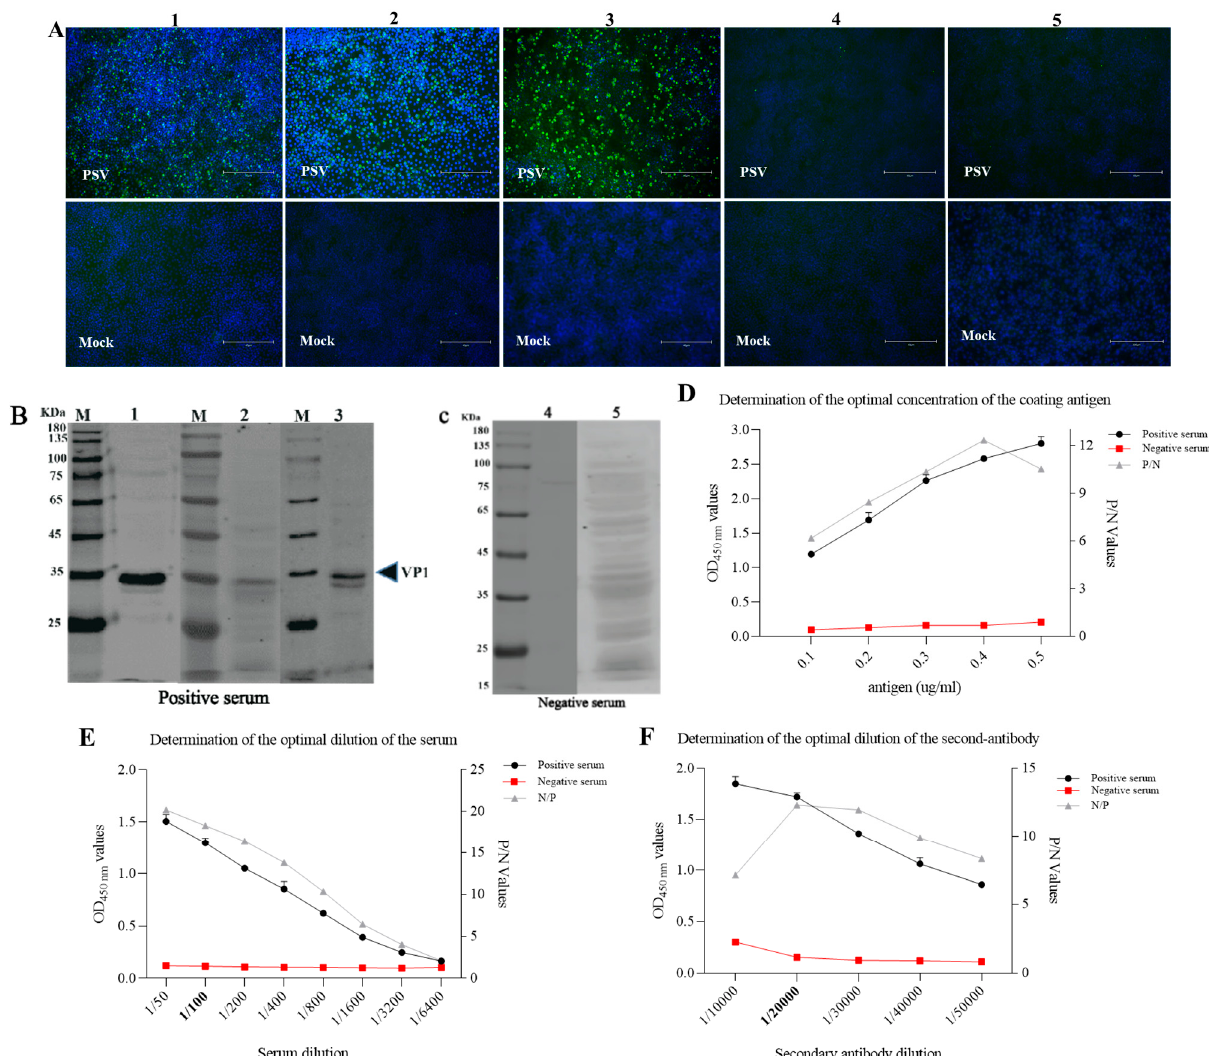
Figure 6. Optimization of reaction conditions of iELISA. ( A ) Verification of PSV-negative and positive swine sera by IFA. PK15 cells were inoculated with PSV at MOI of 0.01. IFA was performed using swine positive serum # 1, 2, and 3, and negative serum # 4 and 5. These are the representative sera of all the tested sera. ( B , C ) Confirmation of PSV positive and negative serum by Western blot. Protein lysates of PK15 cells infected with PSV were detected with PSV positive and negative swine serum respectively. ( D – F ) Optimization of the concentrations of coating antigen, serum dilutions and second antibody respectively.